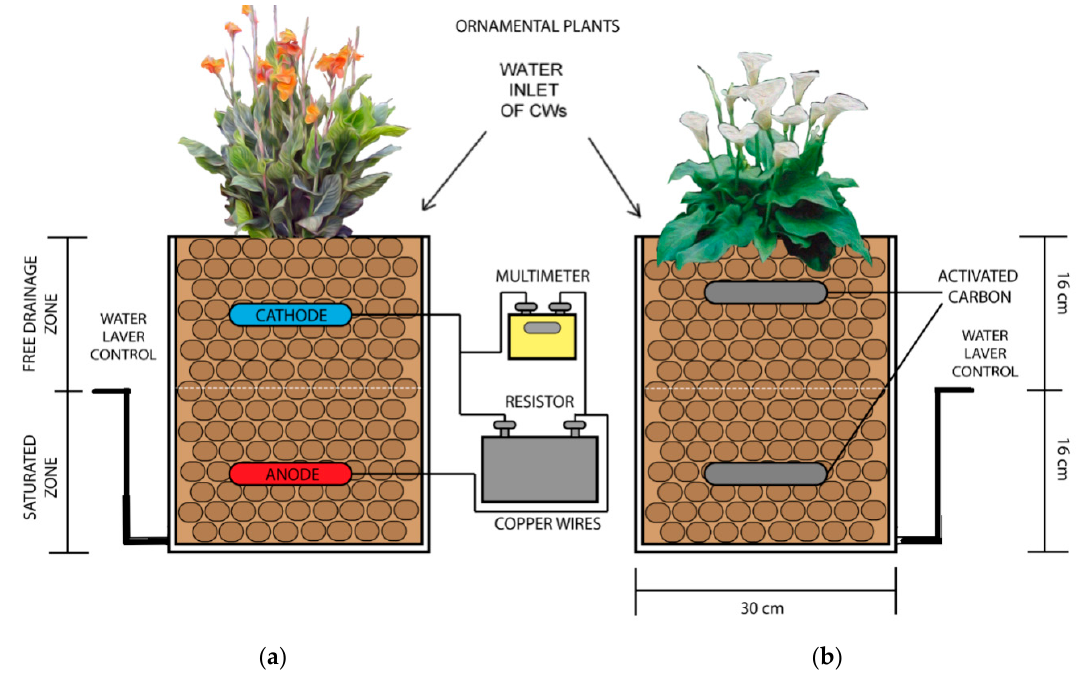
Figure 1. Wastewater treatment system using Canna hybrids ( a ) and Zantedeschia aethiopica ( b ) for bioelectricity production.